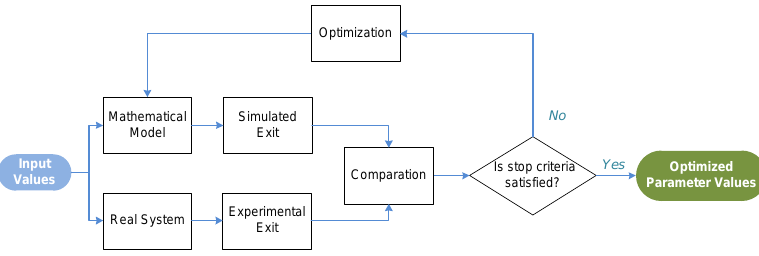
Figure 5. Parametric regression process